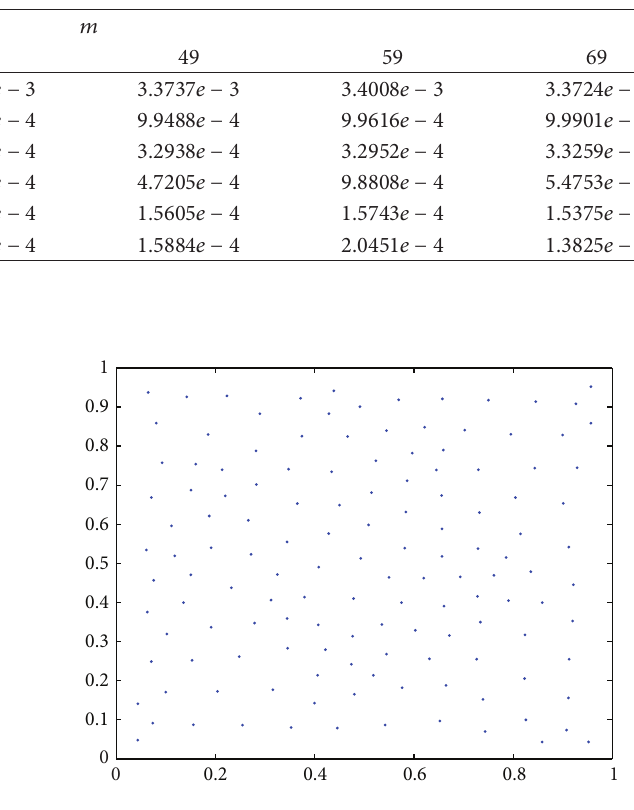
Figure 6: The illustration of the set 𝑋 𝑁 .